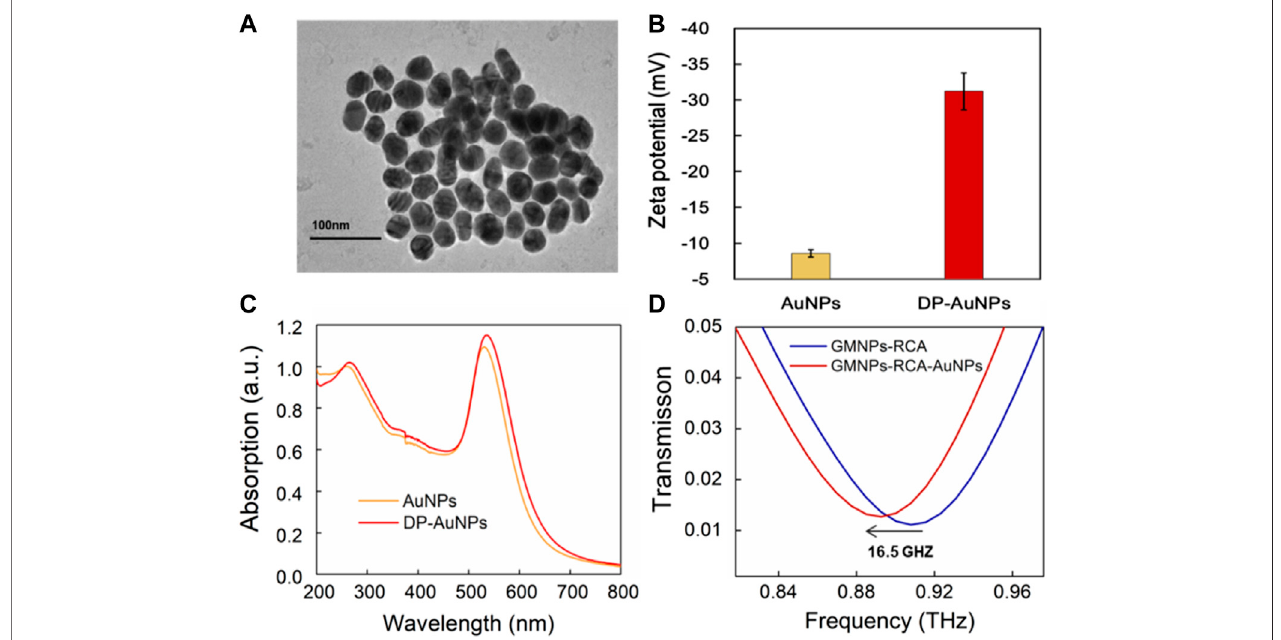
FIGURE 3 | THz measurement for the GMNPs-RCA-AuNPs complex. (A) The TEM images of the AuNPs. (B) The zeta potential of AuNPs and DP-AuNPs. Error bars indicate theSD ( n =3). (C) TheUV-Visible absorbancespectra ofthe AuNPs(Yellow) and the DP-AuNPs(Red). (D) The frequency shiftofTHztransmission spectra for GMNPs-RCA-AuNPs compared to GMNPs-RCA.